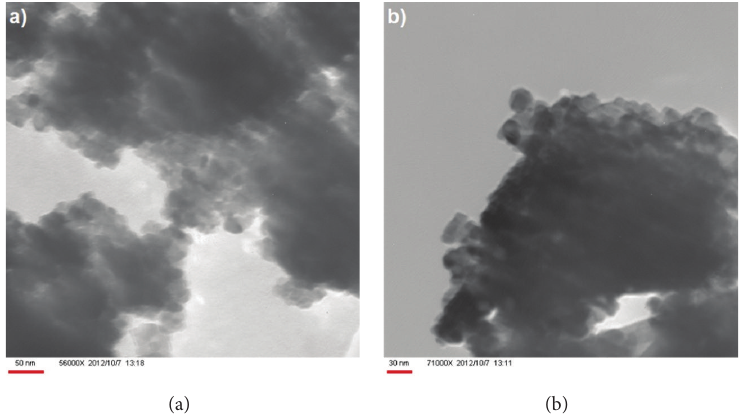
Figure 13: TEM micrographs of the membrane top layer.